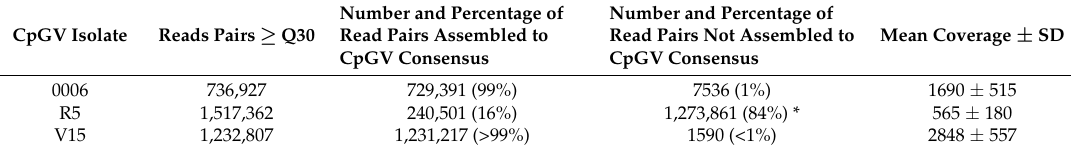
Table 1. Assembly reports of read pairs with an average Phred-quality score ≥ Q30 generated by NextSeq500 next-generation sequencing and assembled against the CpGV alignment consensus sequence using the Bowtie2